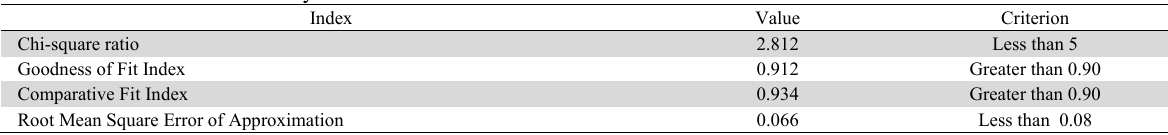
Measurement model fit summary